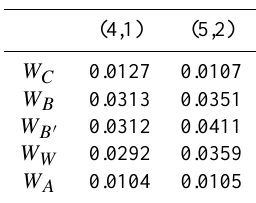
Table 1. Values of W C ,W B ,W B 0 ,W W and W A for emission cross section of N 2 1P (4,1) and (5,2)